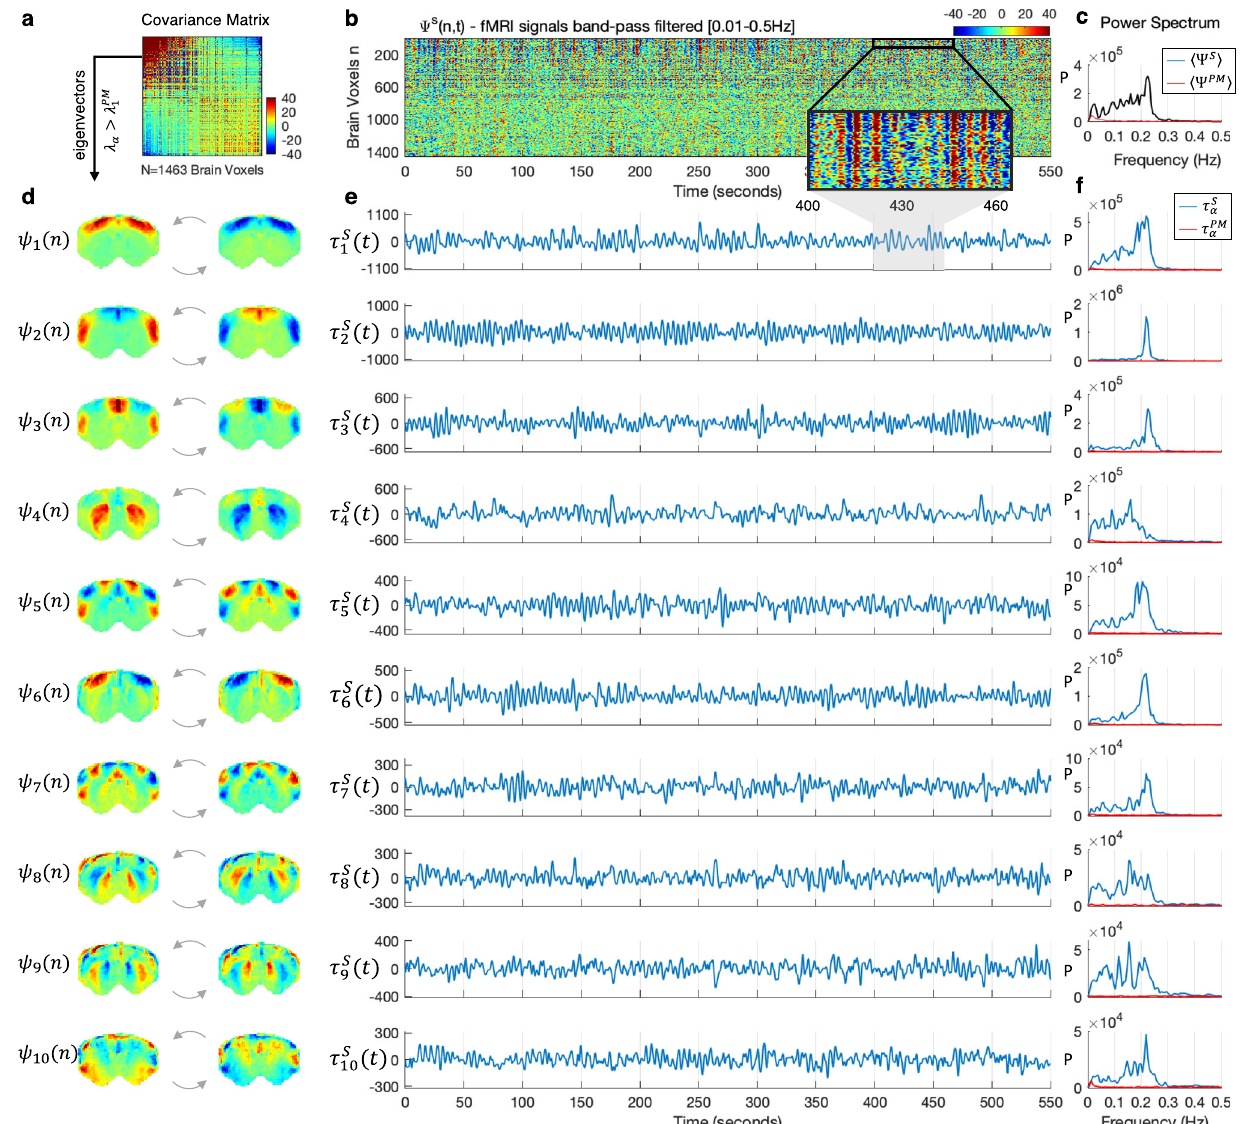
Fig. 3 | Spatial, temporal, and spectral signaturesofthe principal components in medetomidine-sedated rats. a The NxN covariance matrix of fMRI signals ( fi l- teredwithintherangewheresigni fi cantspectralpowerwasdetectedinthecortex, i.e., between 0.01 and 0.3Hz) averaged across the 12 sedated rat scans. b Carpet plot of the fMRI signals in all brain voxels, n , over time, t , represented by the wave function Ψ S ð n , t Þ , here shown for a representative scan S of a sedated rat in the frequency range [0.01 – 0.5Hz]. Voxels are sorted according to the elements in the largest magnitude eigenvector ψ 1 . Values correspond to fMRI signal change with respect to the mean in each voxel. A zoom into the fi rst 100 voxels over 60s is inserted toillustrate oscillationsinthesignals. c Powerspectrum of themeanfMRI